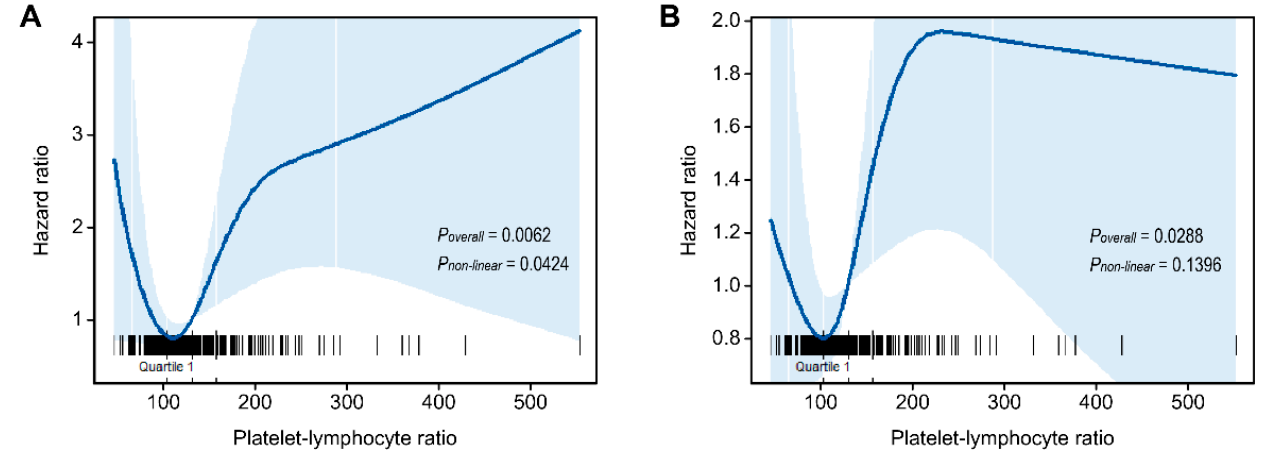
Figure 4. Hazard ratio for the risk of disease-specific death ( A ) and progression ( B ) in oral squamous cell carcinoma patients, evaluated by restricted cubic splines from unadjusted Cox proportional hazard models. The solid line represents the central risk estimate, and the shaded area represents the 95% confidence interval. The rug plot is of cases.